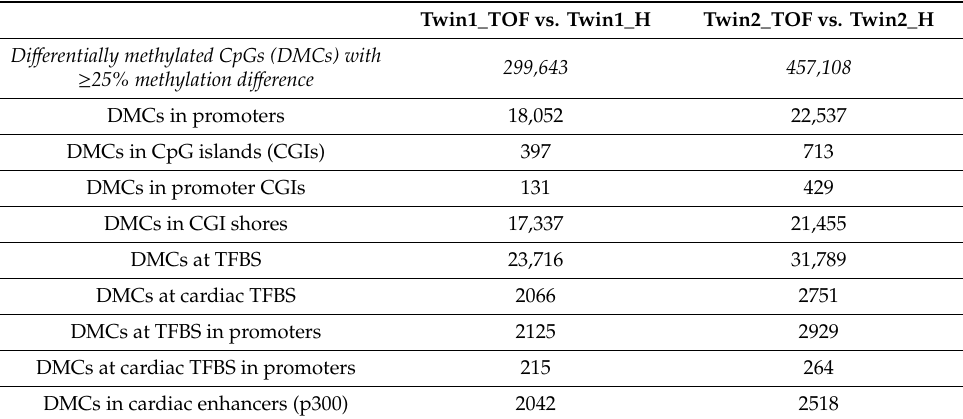
Table 1. Di ff erentially methylated CpG sites with ≥ 25% methylation di ff erence between the healthy and a ff ected twin and their overlap ( ≥ 1 bp) or association (i.e., nearest gene approach) with di ff erent genomic features. CGIs, CpG islands; DMCs, di ff erentially methylated CpGs; H, healthy; TFBS, transcription factor binding site; TOF, Tetralogy of